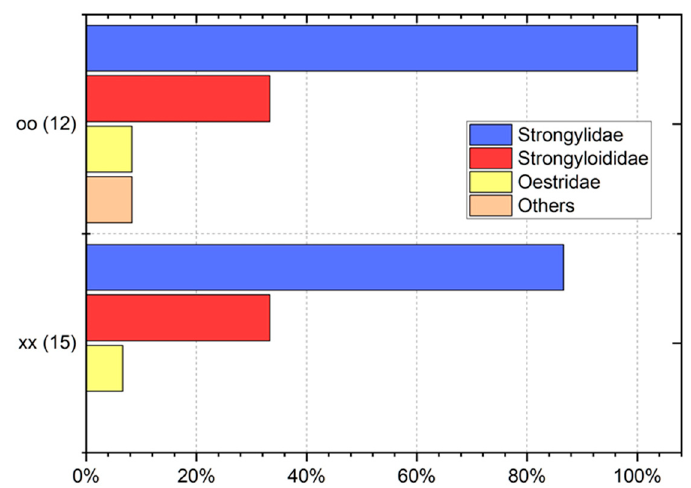
Figure 1. Prevalence of detected organisms in studied horse breeds.